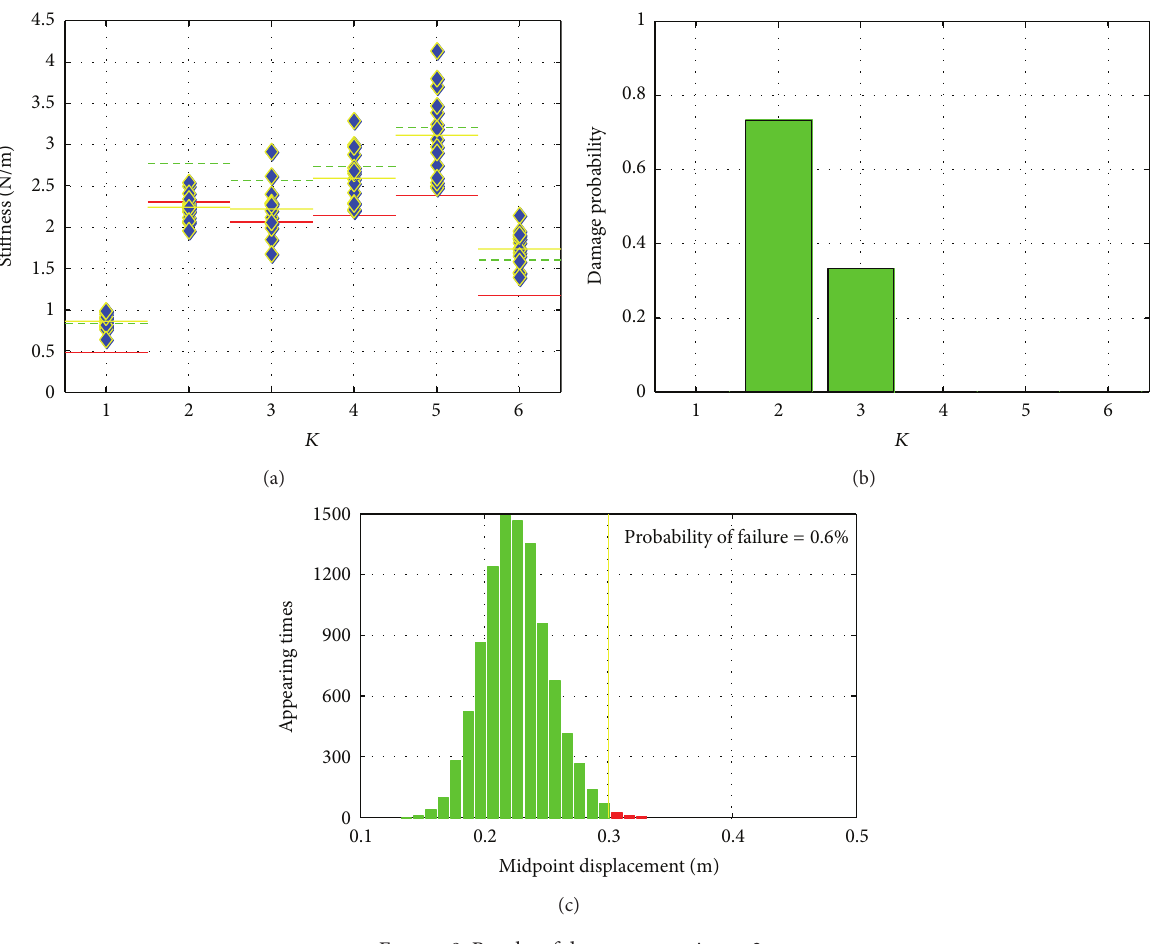
Figure 9: Results of damage scenario no.